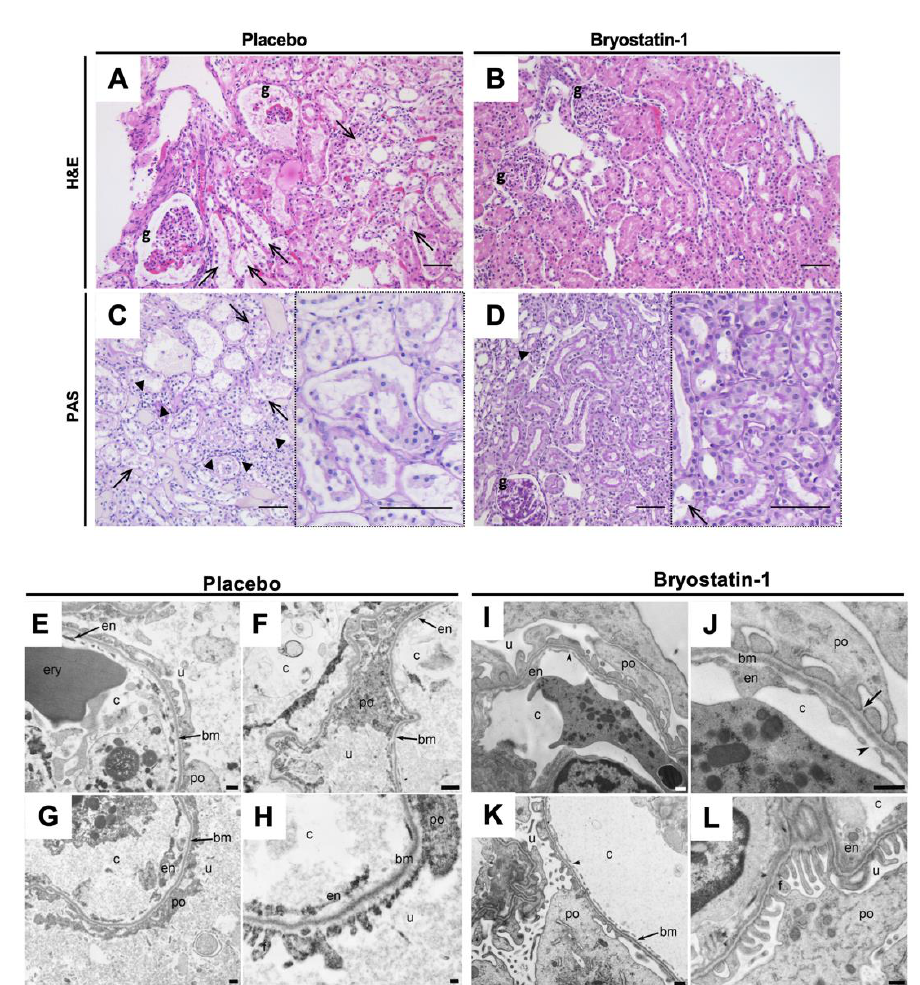
Figure 7. Protective effect of Bryostatin-1 following renal autotransplantation. All analyses were conducted eight hours after reperfusion in a porcine model of renal autotransplantation with graft-specific treatment with placebo or Bryostatin-1 during 20-h static cold storage of renal autografts. ( A – D ) Representative histopathologic images of hematoxylin and eosin (H&E), as well as periodic acid-Schiff (PAS), stained renal biopsies after eight hours of reperfusion: Samples from placebo-treated renal autografts ( A , C ) display striking glomerular shrinkage, distinct inflammatory cell infiltrates (arrowheads), and extensive tubular damage (arrows and ( C ) right panel), all of which were markedly reduced in the Bryostatin-1 group ( B , D ). g: glomeruli, bars: 50 µm. Ultrastructural injury score (consisting of structural integrity of glomeruli, basement membrane, podocytes, and endothelium) was significantly improved in Broystatin-1 treated renal autografts eight hours of reperfusion. Representative electron micrographs of ( E – H ) placebo and ( I – L ) Bryostatin-1 treated renal autografts: ( E ) Transmission electron microscopy in placebo treated renal autografts reveals ultrastructural changes of the endothelium (em) with massive disruptions of the endothelial integrity. Note that the endothelial fenestrations are not distinguishable due to tissue disintegration. In addition, ( F , G ) podocytes (po) and foot processes (f) showed irregular contours with destruction and flattening of the foot processes. As seen in ( H ), the basement membrane (bm) shows an irregular thickness. In comparison to control samples (placebo), ( I ) capillaries from Bryostatin-1 treated samples revealed an intact endothelium with ( J , K ) regular contours and multiple clearly distinguishable fenestrations. Podocytes showed a normal morphology with an intact cytoplasm and clearly visible organelles. ( L ) Foot processes with slit diaphragms and basement membranes reveal all characteristics of a normal glomerular filtration unit. Scale bar for E, G, I, J, K 500 nm, for F, H, 200 nm and for L 1 µm; c = capillary lumen, ery = erythrocyte, u = urinary space, arrow = slit diaphragms; arrowhead = fenestration.